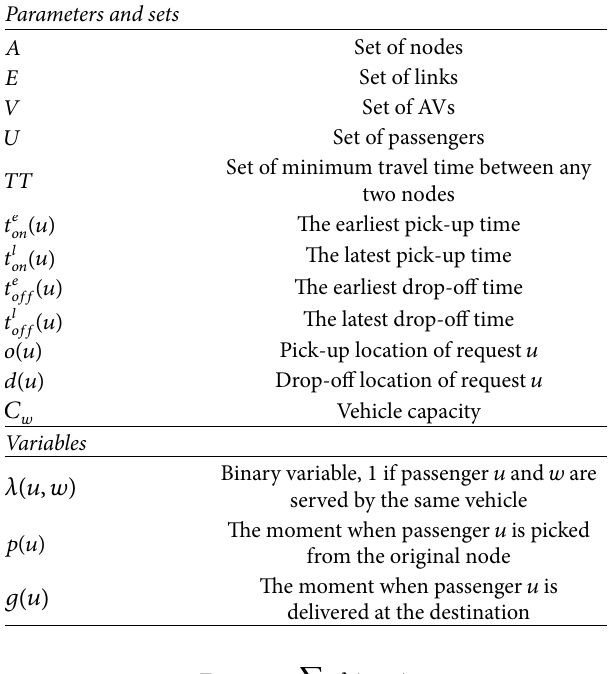
Figure 1: The framework of the AV transportation system. Table 1: Summary of